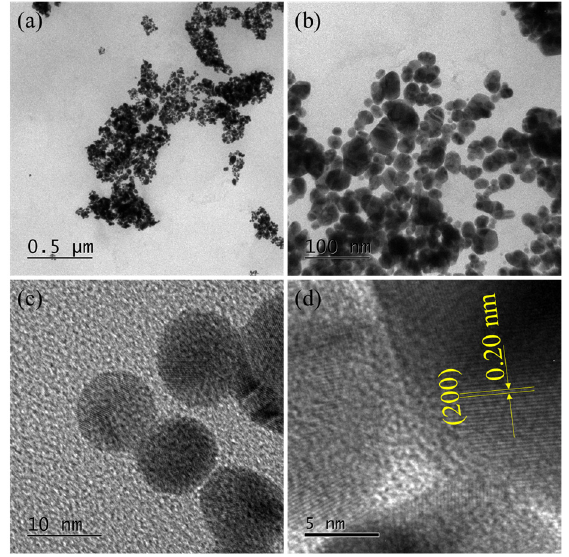
Figure 3. TEM images of AuNPs ‐ DNS. ( a , b ) AuNPs with low magnification and ( c , d ) AuNPs with high